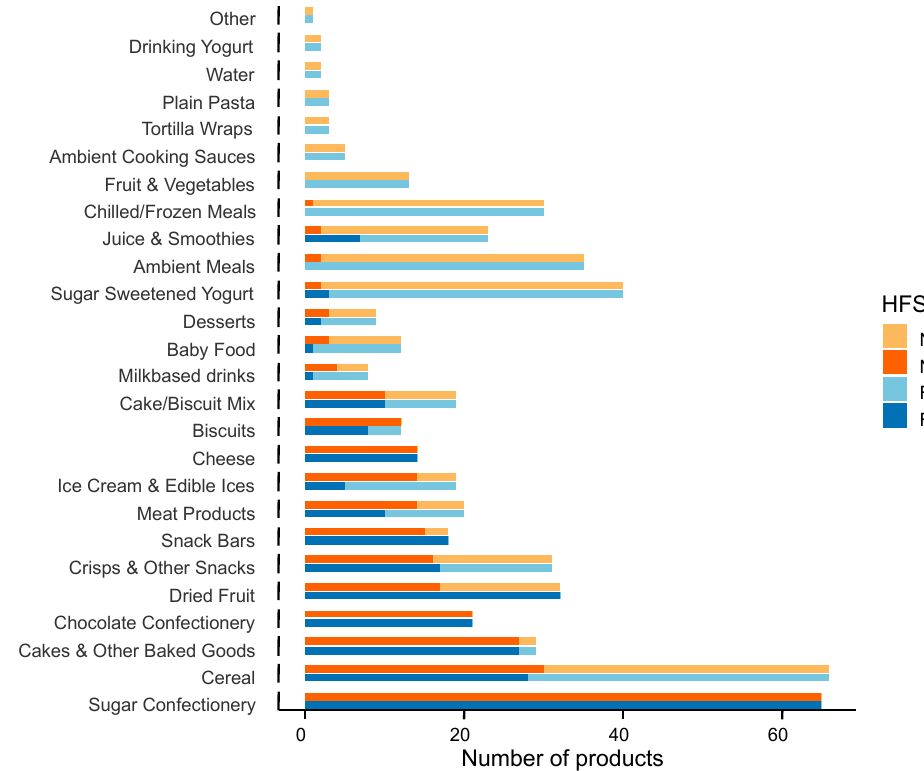
Figure 1. Summary of products by category, highlighting HFSS products as determined by the Nutrient Profiling Model (NPM) and UK Front of Pack nutrition labelling system